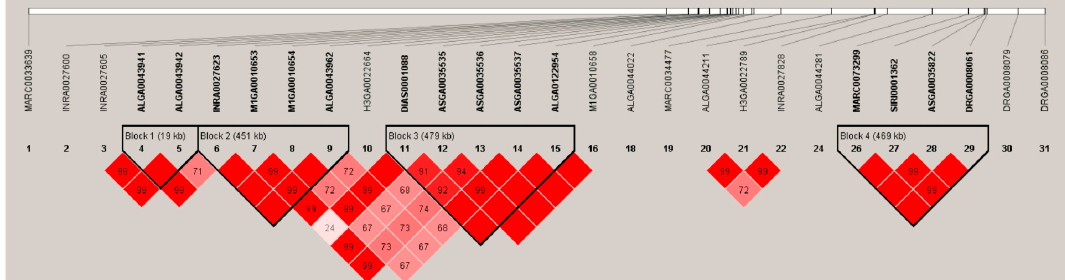
Figure 2. Haplotypes on a 25.76-Mb region on SSC7 containing all SNPs associated with the NTV significantly. The analysis was obtained using the HAPLOVIEW 3.31 program. A total of four blocks were identified and marked with solid lines.